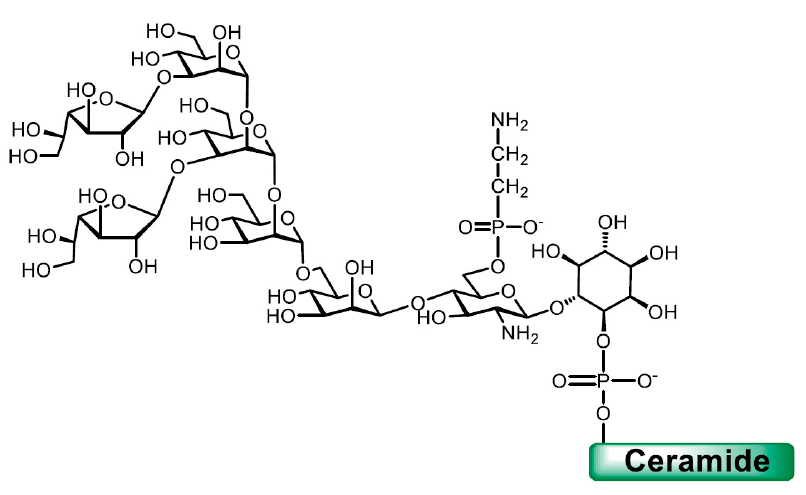
Figure 5. Major structure found in glycoinositolphospholipids (GIPLs) of the Y strain.